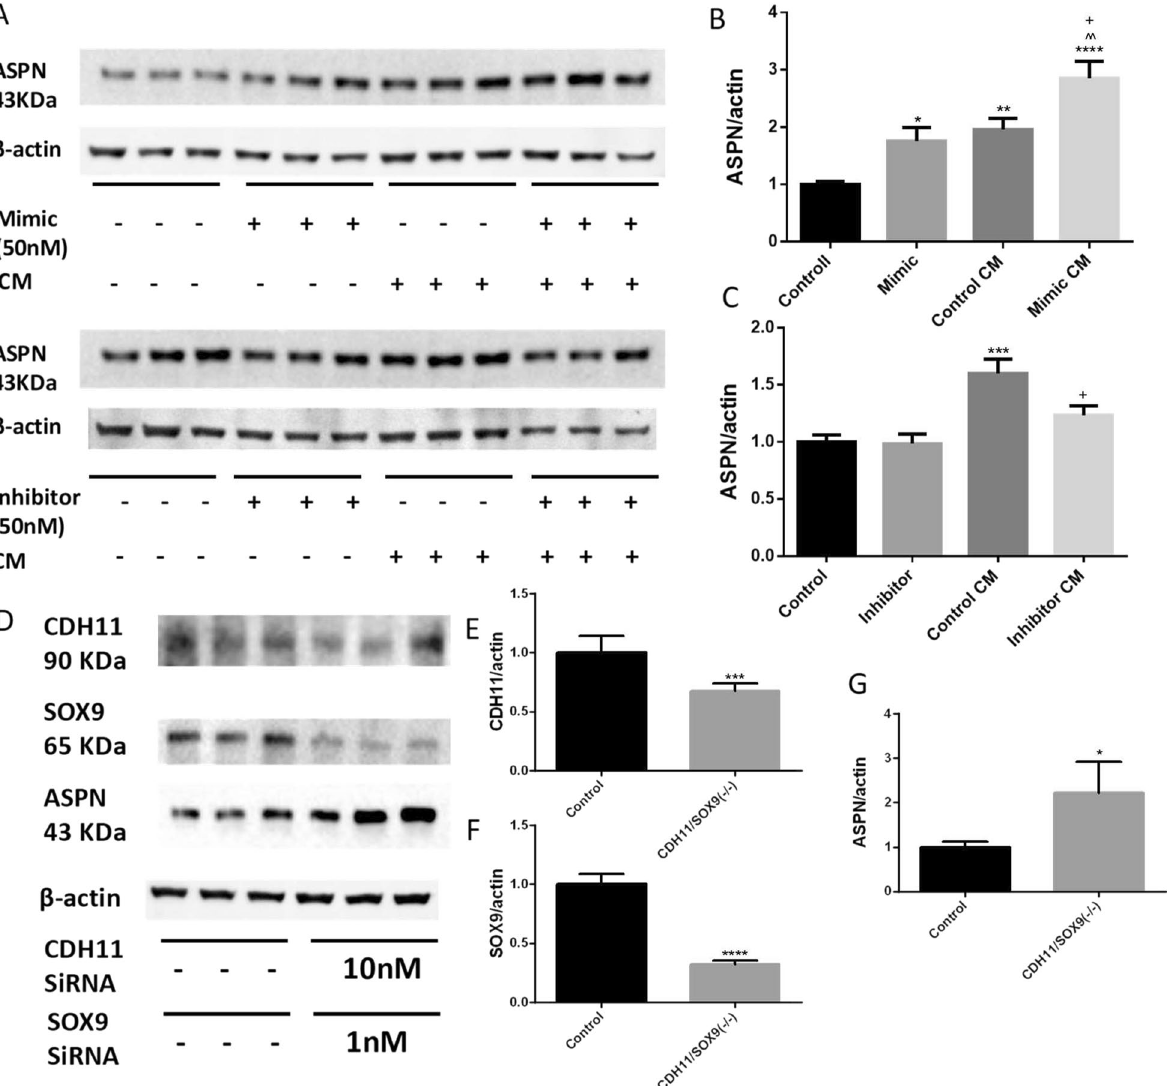
Fig. 7 miR-101 mediated ASPN expression in CM treated HAVICs through regulation of CDH11 and Sox9. A Western Blot against antibodies of ASPN in HAVICs transfected with miR-101-3p mimic or inhibitor for 48 h and then treated with CM for 48 h. β-Actin serves as internal loading control. B , C Quantifications of ASPN protein expression normalized with β-actin. *P < 0.05 and ****P < 0.0001 vs Control; + P < 0.05 and ++ P < 0.01 vs Control, CM; ^^P < 0.01 vs Mimic. D Western Blot against CDH11, Sox9 and ASPN in HAVICs co-transfected with SiRNAs of CDH11 (10 nM) and Sox9 (1 nM) for 72 h. E – G Quantifications of WBs normalized by β-actin. Data means SEM. ***P < 0.001 and ****P < 0.0001 vs Control. n 3 = ± =